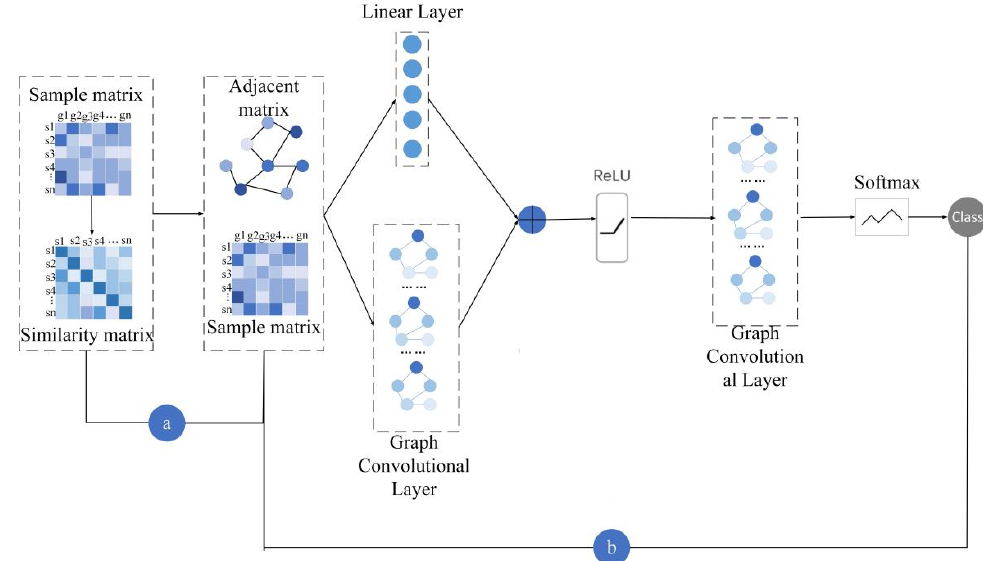
Figure 1. Framework of the ERGCN. ( a ) Calculate sample similarity matrix according to the Pearson correlation coefficient of their gene expression data and construct the sample adjacency matrix. ( b ) Input the sample features and the sample adjacency matrix into the residual graph convolution model to obtain category prediction.